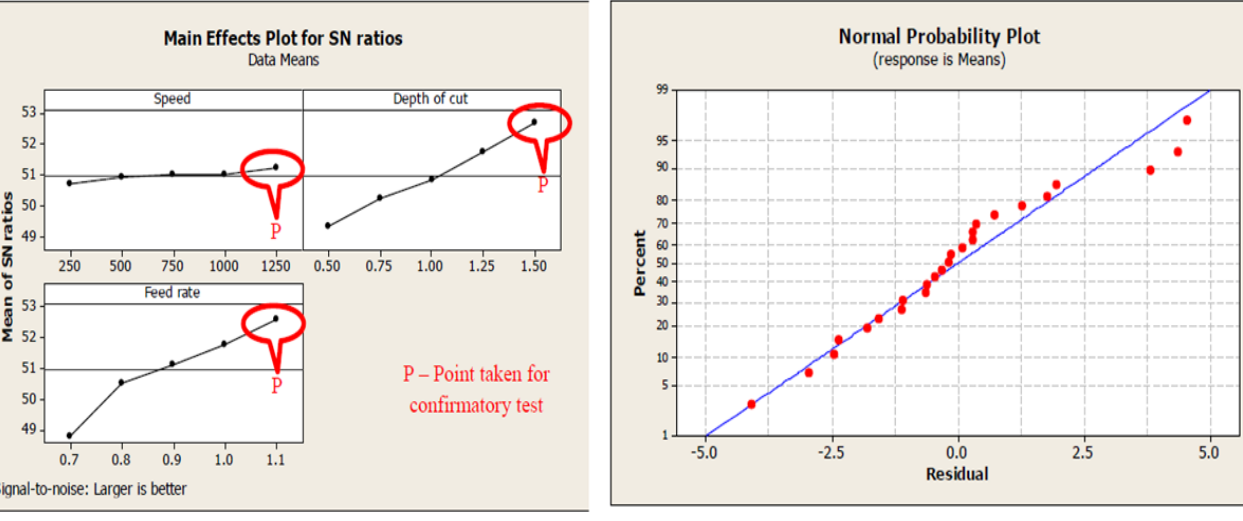
Figure 6. SN ratio and curve fitting for Nano multilayered Titanium-coated tool inserts.